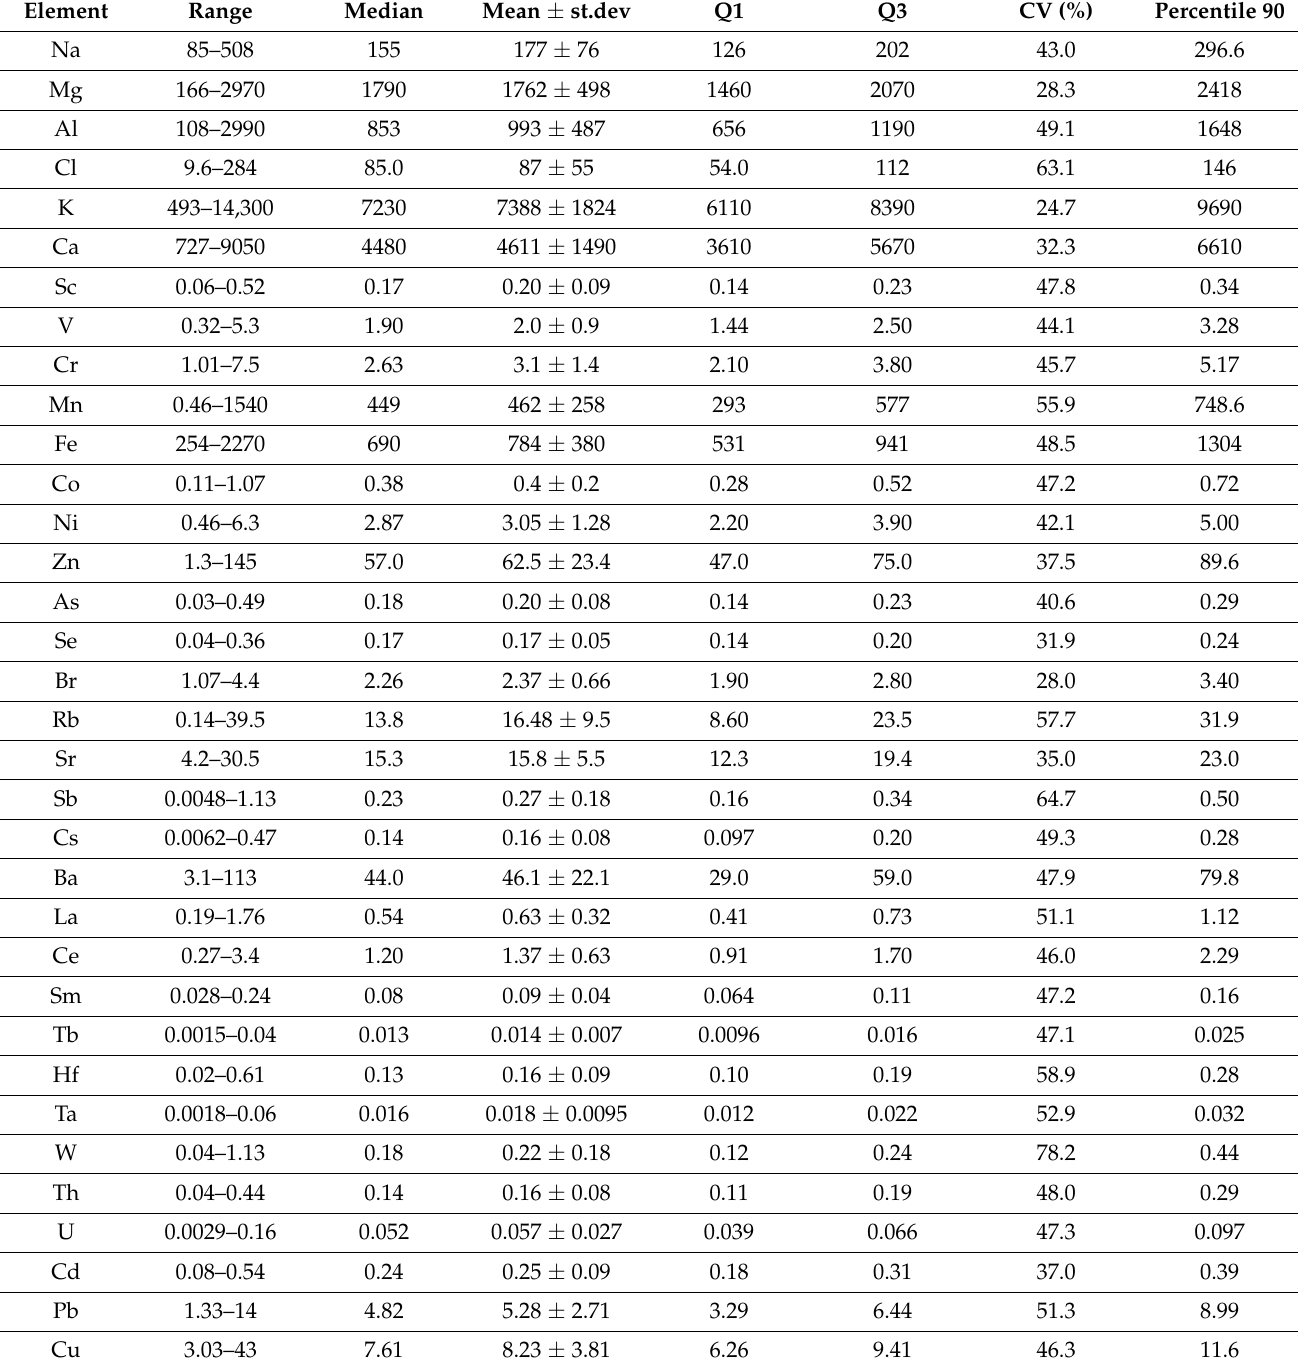
Table 2. Descriptive values for major and trace elements in mosses collected in 2020 in the Moscow region, in